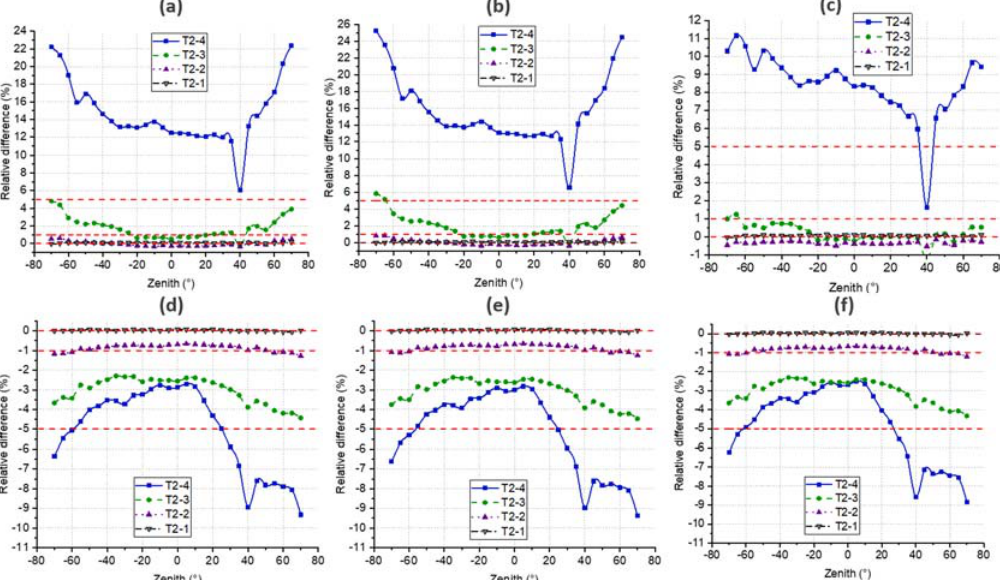
Figure 17. Relative difference for the second stage, ( a ) 650 nm, ( b ) 670 nm, ( c ) 700 nm, ( d ) 750 nm, ( e ) 800 nm, and ( f ) 850 nm. The dashed lines in red represent the relative difference of 1% and 5%.